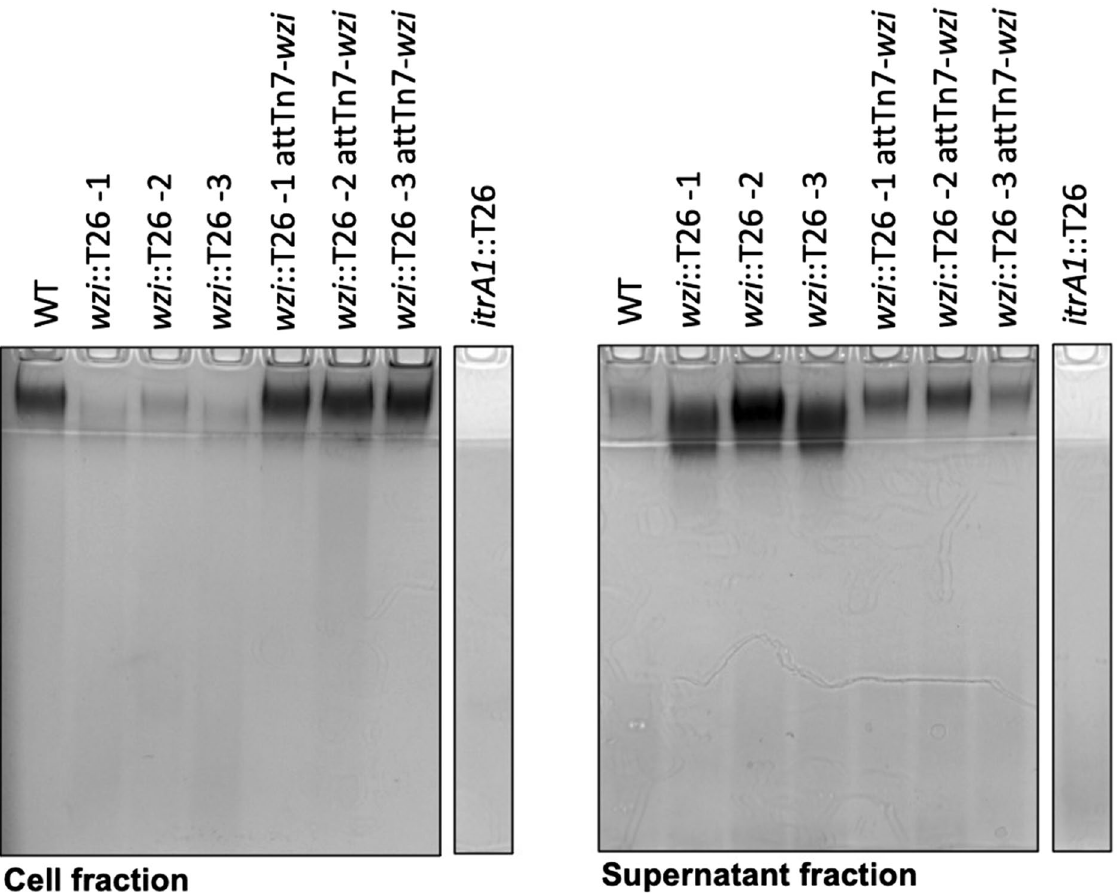
Figure 2. CPS phenotypes of A. baumannii wildtype, wzi and itrA1 mutants. Purified capsular polysaccharide from A. baumannii cells and supernatants. Samples were visualized by SDS-PAGE and stained with Alcian blue. Cell fraction represents the proportion of CPS attached to the cell surface, while polysaccharide in the supernatant represents CPS shed from the cell surface. Strain names are shown above each well. Original uncropped gel images are provided in Fig.